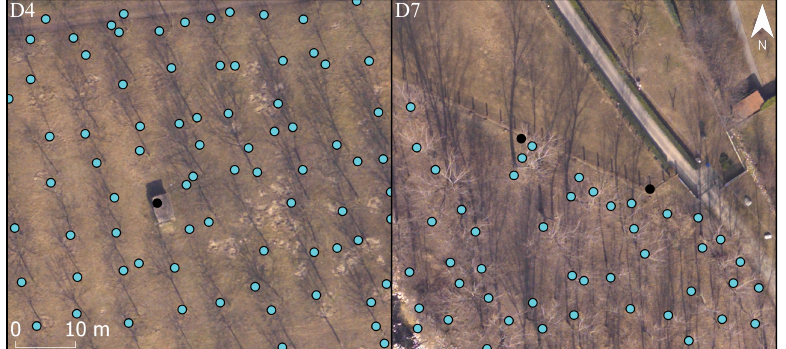
Figure A1. Detected treetops before (black dots) and after (cyan dots) the application of the filter to remove not-natural objects in D 4 and D